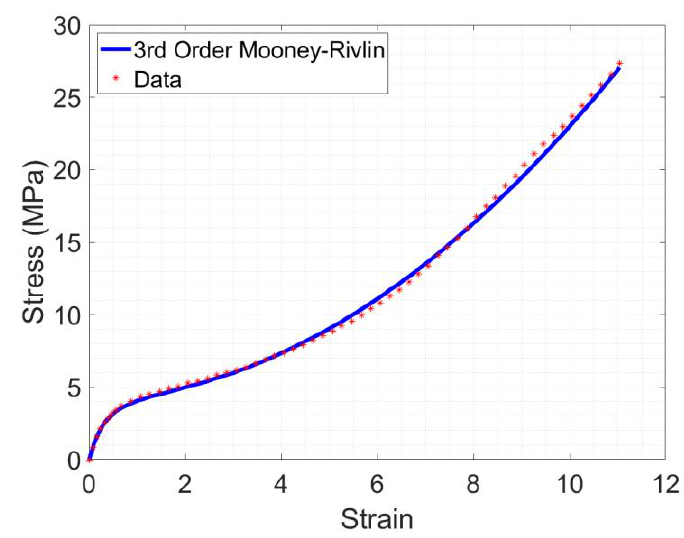
Figure 4. Third-order Mooney – Rivlin model fit to uniaxial tensile test data. Lastly, λ i represents the stretch of the specimen, or λ = 1 + ε , with ε being the strain. C 10 , C 01 , and C 11 are listed in Table 3. Table 3. Model parameters for the 3 rd order Mooney–Rivlin model used in the FEA model. C10 C01 C11 D1 − 80,337 2,348,300 30,693